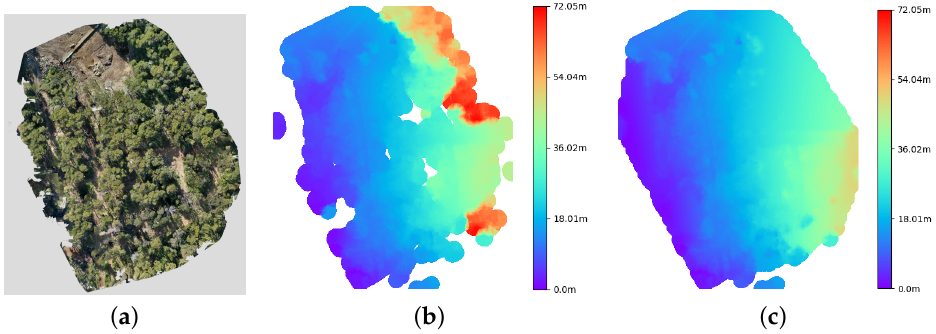
Figure 14. Original orthomosaic of the relevated area ( left ), DTM with the Default algorithm of ODM ( middle ) and DTM corrected with our method. ( a ) Orthomosaic. ( b ) Default. ( c ) Proposed